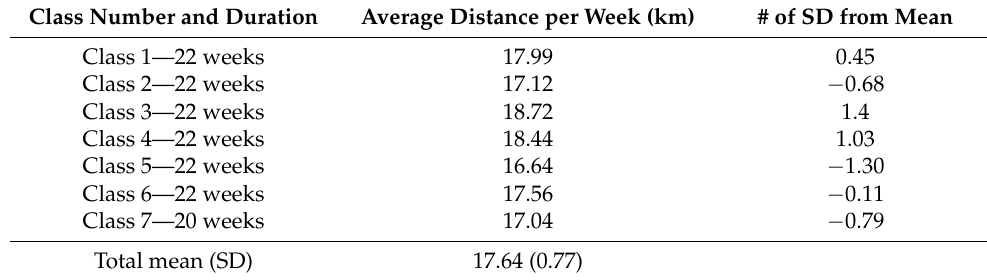
Table 2. Average distance per week per class during academy training. Class Number and Duration